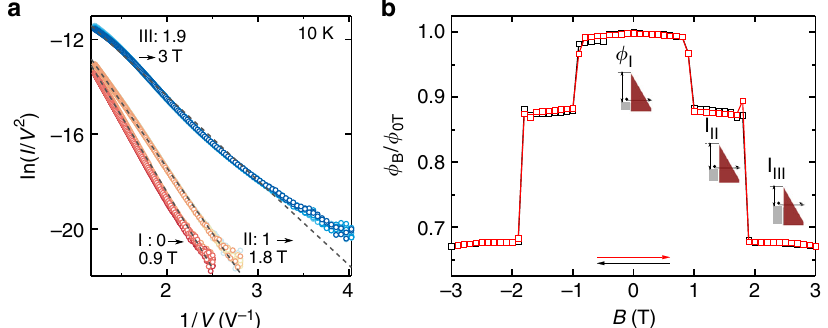
Fig. 6 Coupling between magnetic state and tunneling resistance of CrI 3 a , Plot of ln( I / V 2 ) as a function of 1/ V for B ranging between 0 and 3 T showing a nearly linear behavior with a B -dependent slope ( T = 10 K). All data collapse on three different curves. b Magnetic fi eld dependence of the barrier height extracted from the slopes of the curves in a , using Eq.